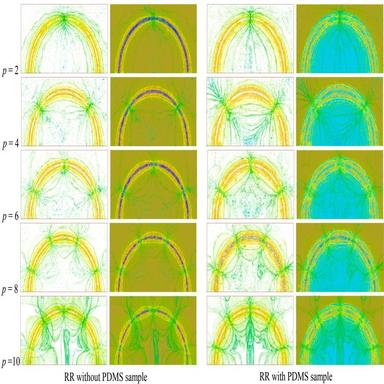
Electric field distribution of the first even modes (p = 2, 4, 6, 8, 10) in the ring resonator without (at left) or with PDMS sample (at right) (top view) using 3D Model 2.